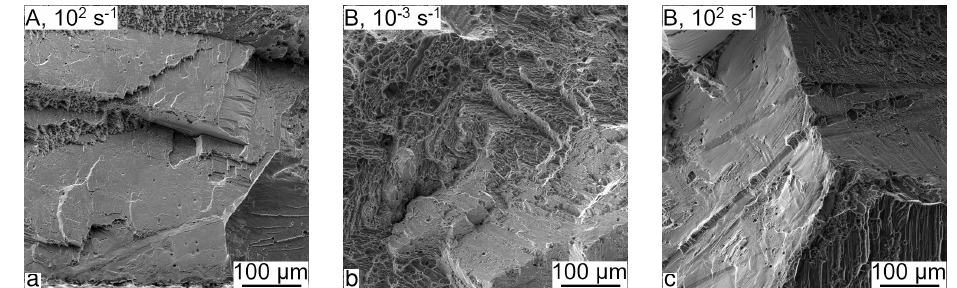
Fig. 6: Fracture surfaces of material A (a) and material B (b +